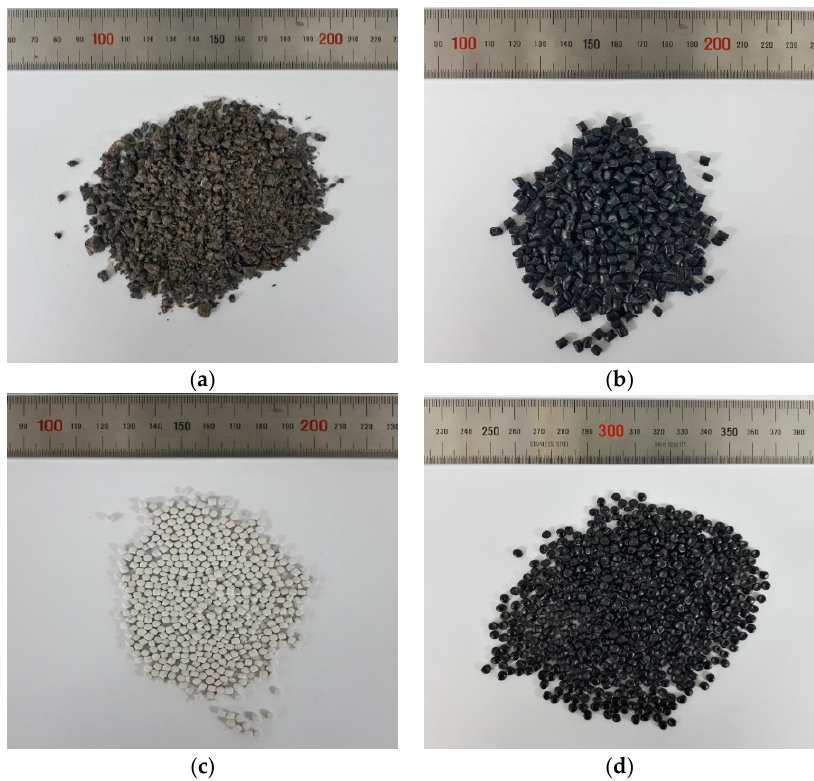
Figure 2. Pelletized raw materials: ( a ) MPW, ( b ) recycled high-density polyethylene (RHDPE), ( c ) calcium carbonate (CaCO 3 ) calpet filler (CCF) and ( d ) antistatic agent. Table 1. Density of raw materials (unit: g/cm 3 ).